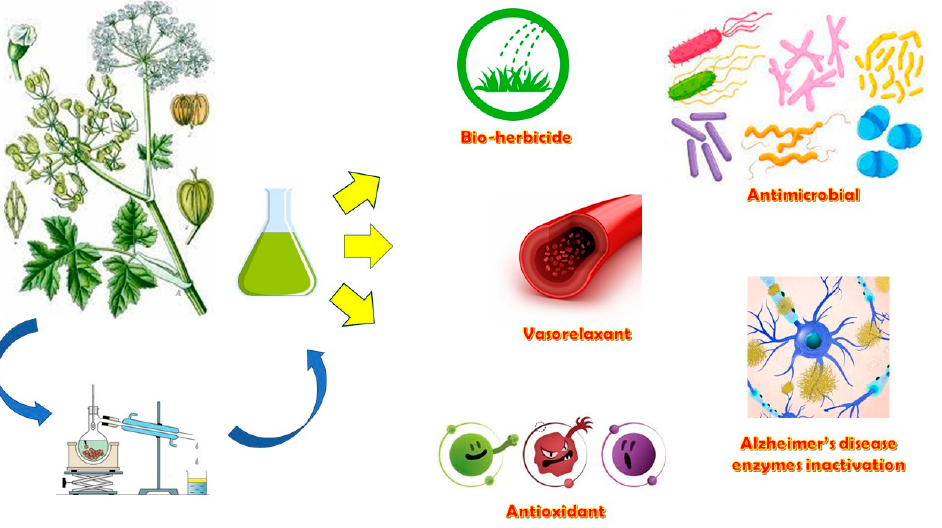
Figure 8. Graphical representation of the different biological activities attributable to H. sphondylium .